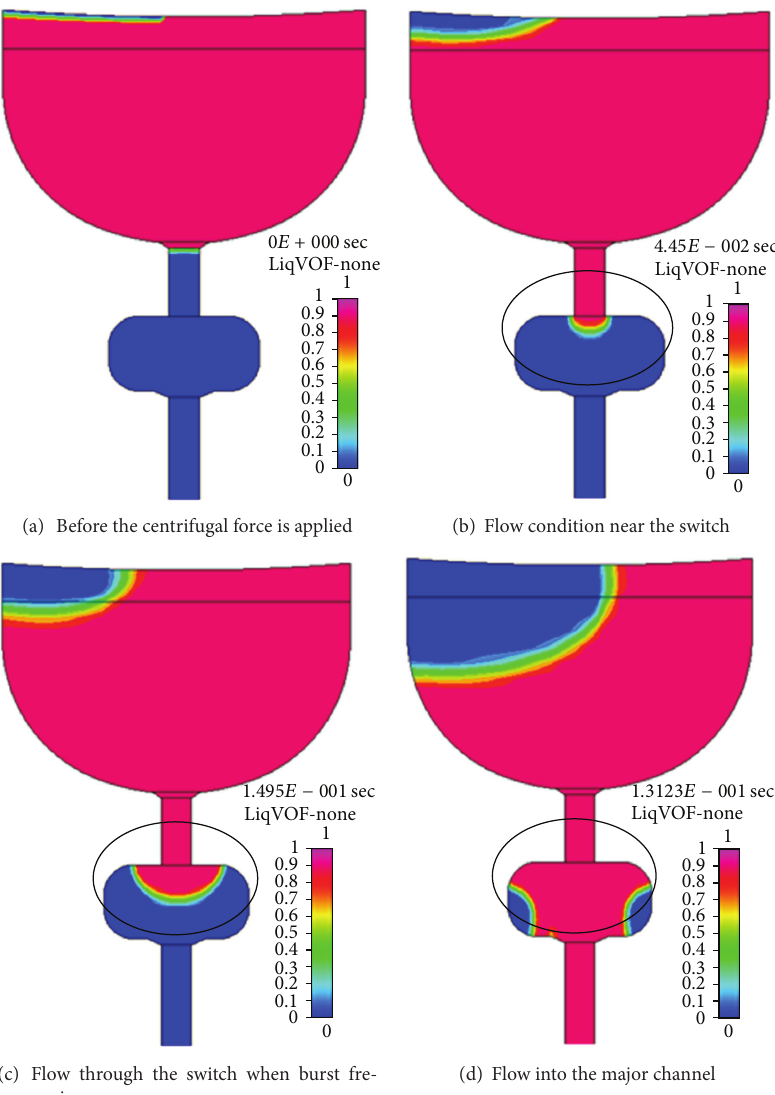
Figure 12: Flow condition at different positions simulated by CFDRC.